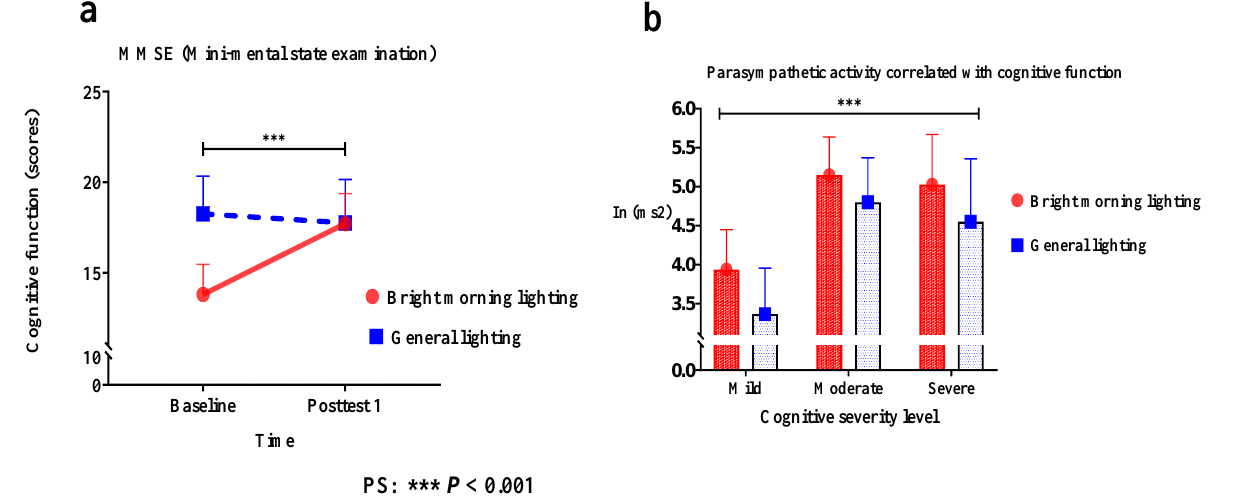
Figure 6. ( a ) Exposure to bright morning light (BML) significantly improved MMSE scores (Wald’s test = 4.4, p < 0.001) from baseline to posttest 1 compared with exposure to general lighting. A main effect of lighting type on cognitive function was observed. A significant change in the slope indicated improved cognitive function. ( b ) The treatment group demonstrated a significant association between cognitive function and high-frequency (HF) power (Roy’s largest root = 1.41; p < 0.001). Bright morning light (BML) exposure enhances parasympathetic nervous system (PSNS) activity at night, which is more effective for severe dementia than for moderate and mild dementia.